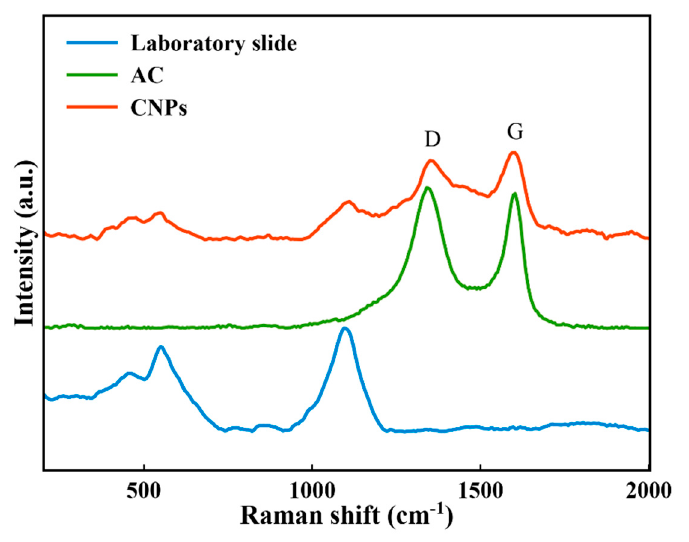
Figure 7. Size distribution of the synthesized CNPs.